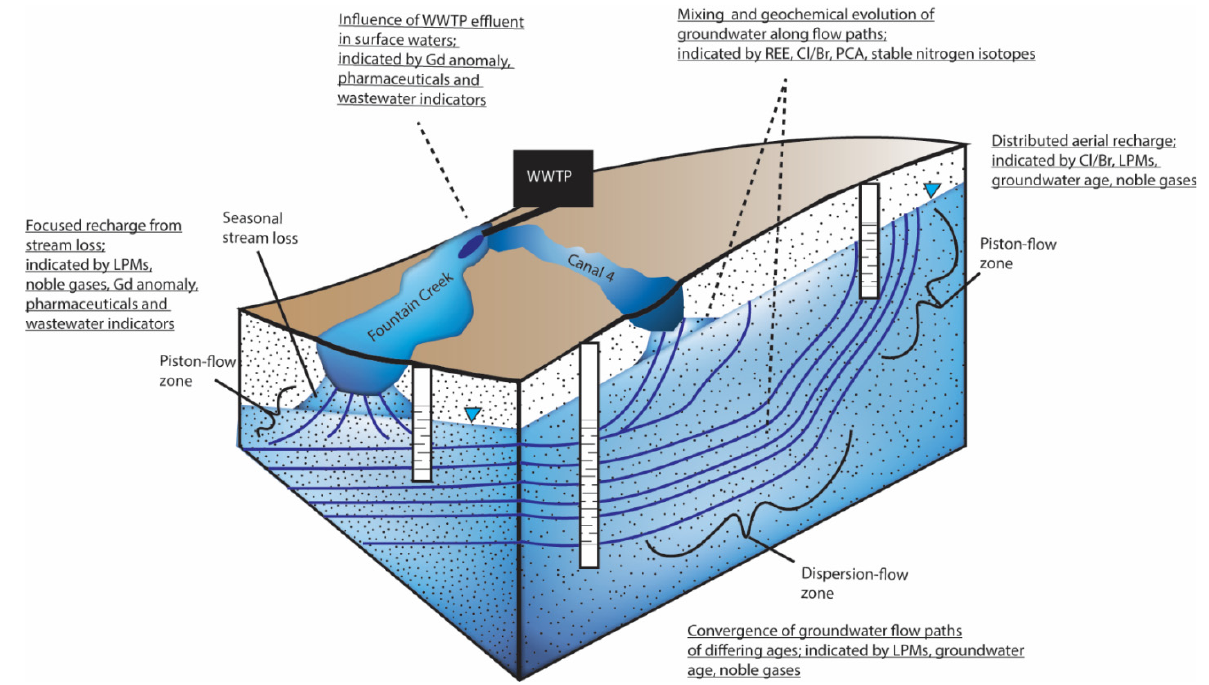
Figure 9. Conceptual hydrologic model highlighting processes occurring in the system (indicated by black type and solid black lines) and the means by which those processes were recognized (indicated by underlined type and dashed black lines).